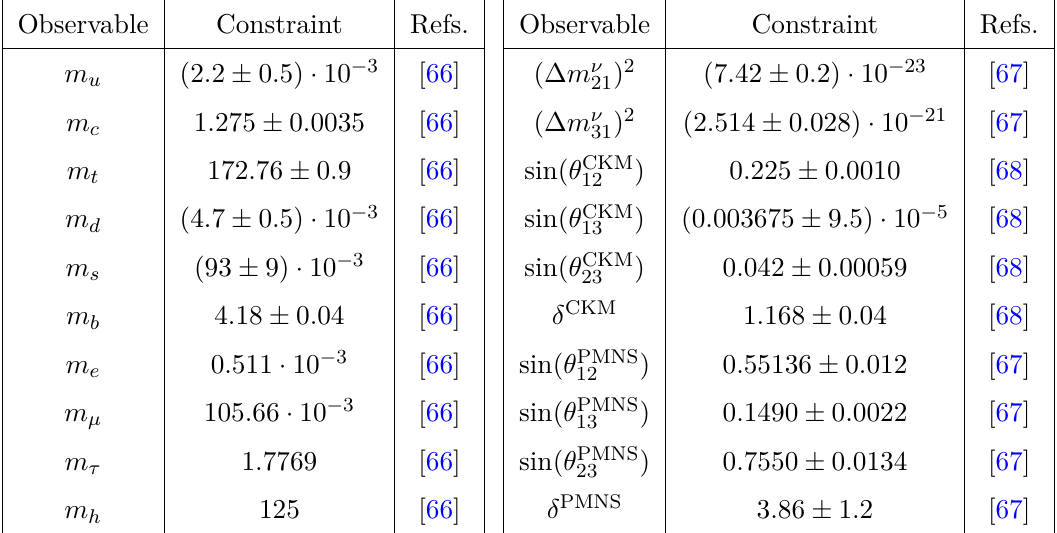
Table 3 . ν SM parameters, masses and EWSB constraints for our model exploration. All masses are given in GeV and are pole masses, except for the bottom and light quarks: the bottom (light quarks) one is the MS mass given at the scale Q = m ( µ = 2 GeV). Theoretical uncertainties of 1% b are assumed for the different masses and are added in quadrature with the experimental ones. Note that the charged lepton and Higgs boson mass experimental uncertainties are negligible with respect to the theoretical ones and are therefore omitted.